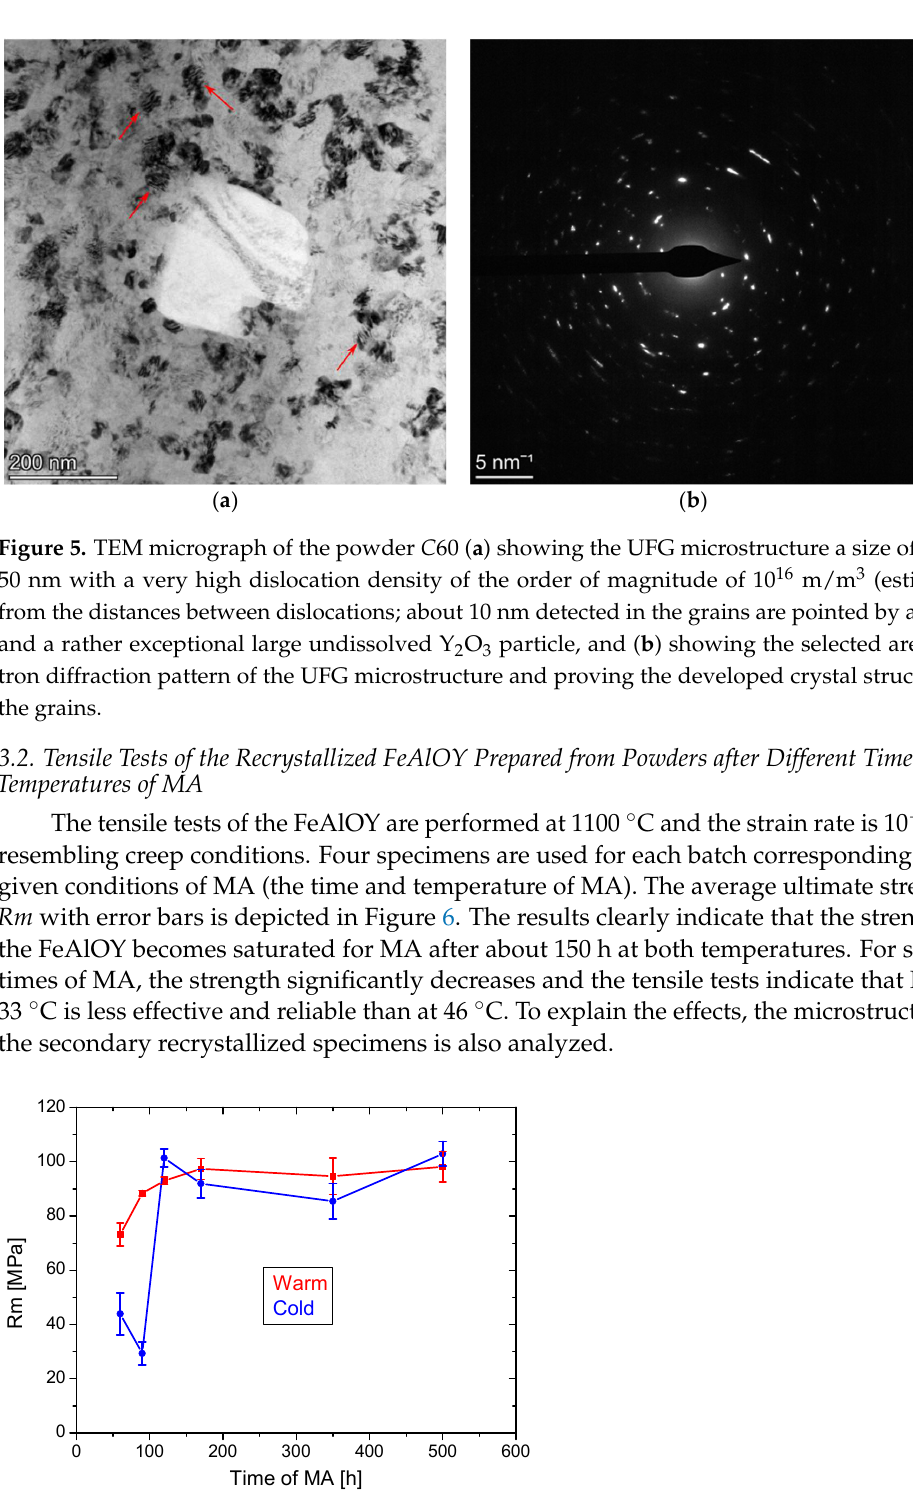
Figure 6. Dependence of average ultimate strength Rm on the time of MA.